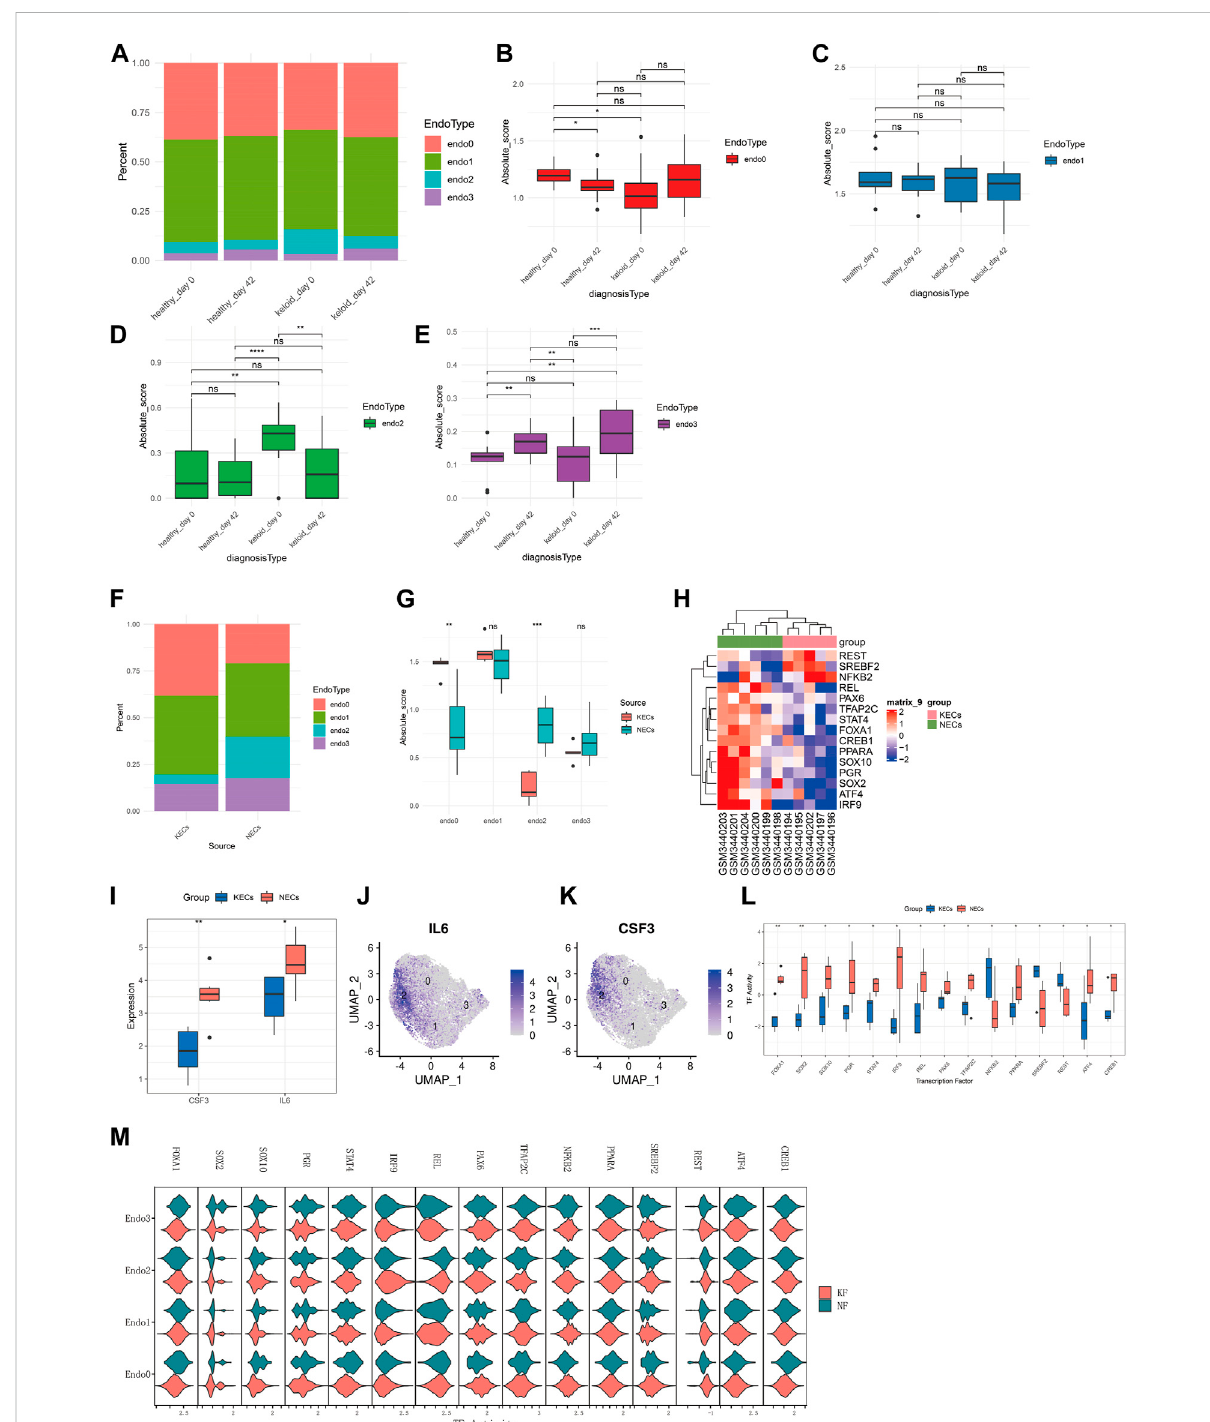
FIGURE 3 Bulk-RNAseqtoexploretherelationshipbetweenfourendothelialcelltypesandkeloidogenesisanddevelopment. (A) Comparisonofthedistributionofthe four endothelial cells of GSE113621 in different pathological states. (B – E) Comparison of the differences between the four endothelial cells respectively. Endo0scoredtheleastinkeloid_day0;Endo1didnotdiffersigni fi cantlybetweenthefourgroups;Endo2scoredthehighestinkeloid_day0;Endo3rosesigni fi cantly afterkeloidformationonday42,bothinhealthyindividualswithnormalscarsandkeloid-pronepatients. (F) Distributionofthefourendothelialcelltypes(NECs vs. KECs) for the 11 endothelial cell transcriptome data from GSE121618. (G) Endo0 was signi fi cantly higher in KECs, whereas Endo2 was signi fi cantly lower. No signi fi cant differences were found for Endo1 and Endo3 ( t -test). (H) Analysis of differential transcription factor activation. (I) Comparison of transcription factor activities. (J) CSF3andIL6weresigni fi cantlyreducedinKECs,whichisconsistentwiththereducedlevelsofEndo2. (K,L) IL6andCSF3aresigni fi cantlyenrichedin Endo2atthesingle-celllevel. (M) Comparisonofthedifferencesinactivityof15transcriptionfactorsinNFandKFatthesingle-celllevel.Thisresultdemonstratesthat the differences in transcription factor activity between Endo2 and Endo0 are consistent at the single-cell level and at the transcriptome